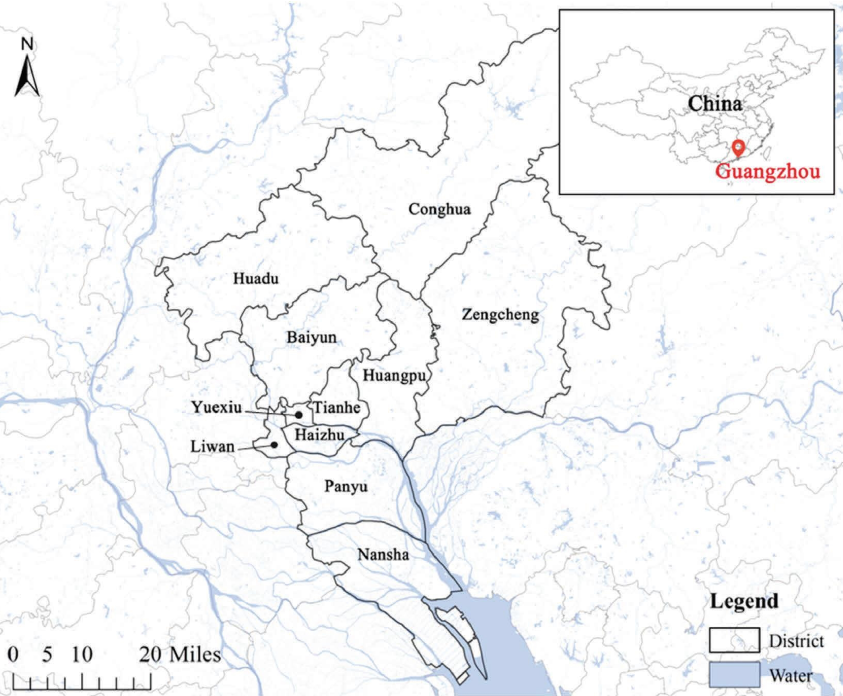
Figure 2: Eleven administrative districts of Guangzhou selected for empirical study